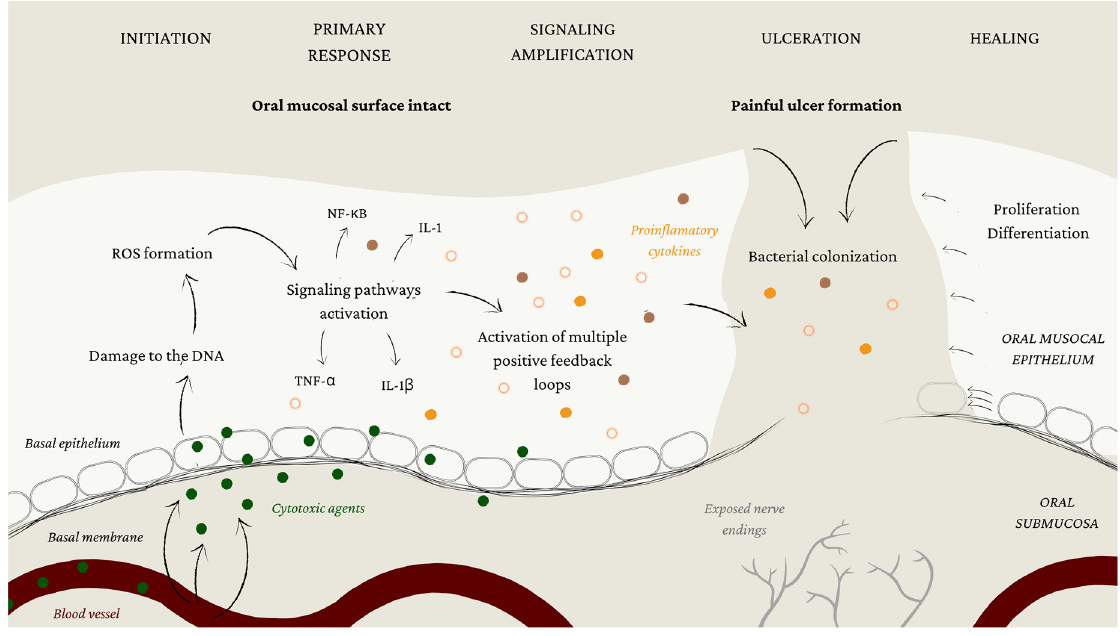
Figure 2. Oral mucositis pathobiology.